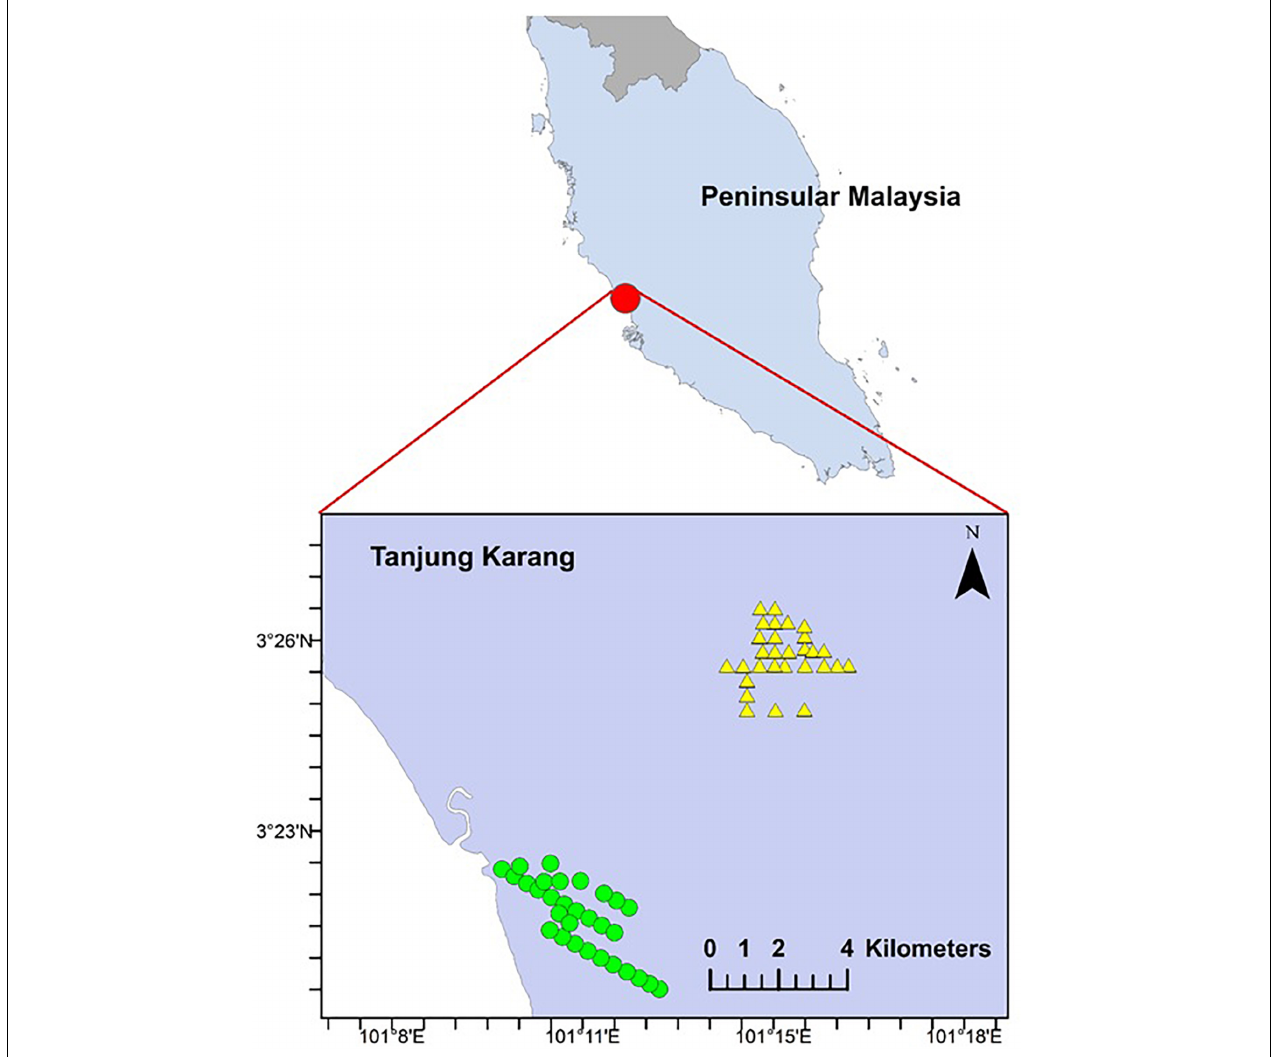
FIGURE 1 | Map of the study area in Peninsular Malaysia and 60 sampling sites in Tanjung Karang. Mangrove forest-converted smallholdings and peat swamp forest-converted smallholdings are denoted by circle and triangle shape, respectively.